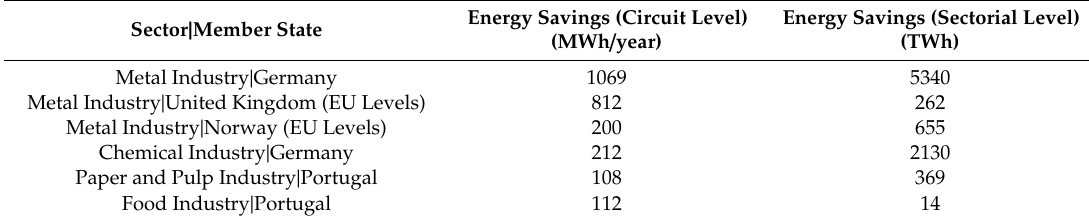
Table 13. Potential energy savings in each industrial sector at EU